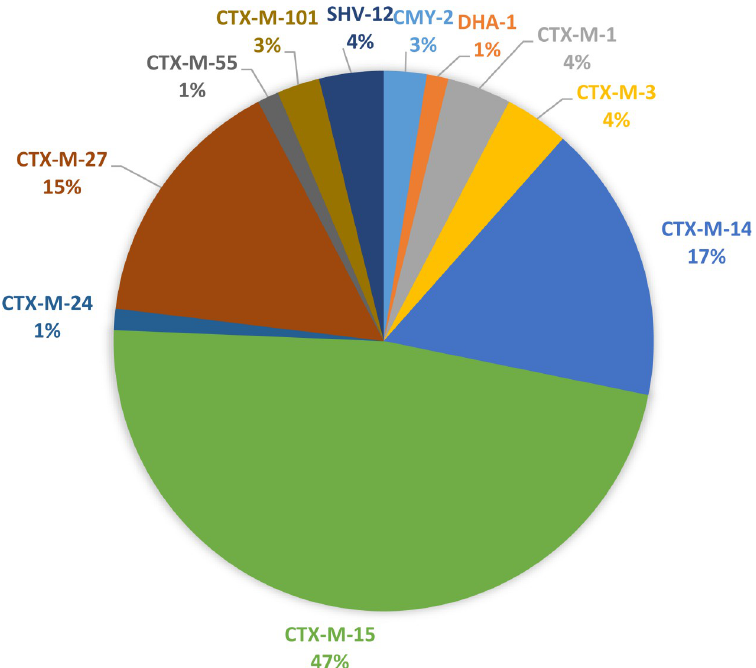
Fig 3. Distribution of ESBL genes in blood isolates of culture-confirmed community-onset-BSI with ESBL-Ec in blood with pheno- and genotypically matched urine isolates, UPEC (n = 77), taken 0–7 days prior the blood culture. Registered and treated in southeast of Sweden, 2009–2018.